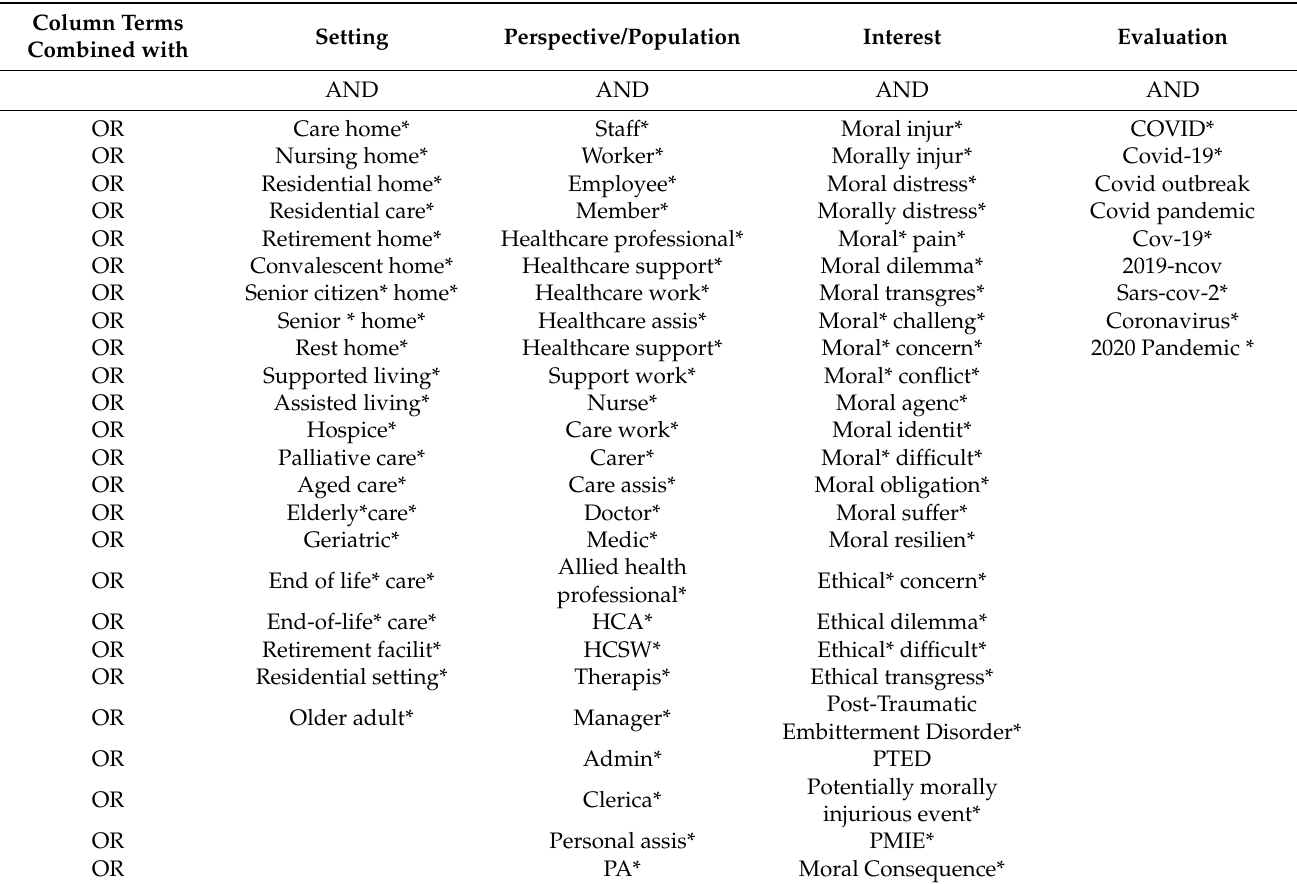
Table 2. Database search terms using Boolean